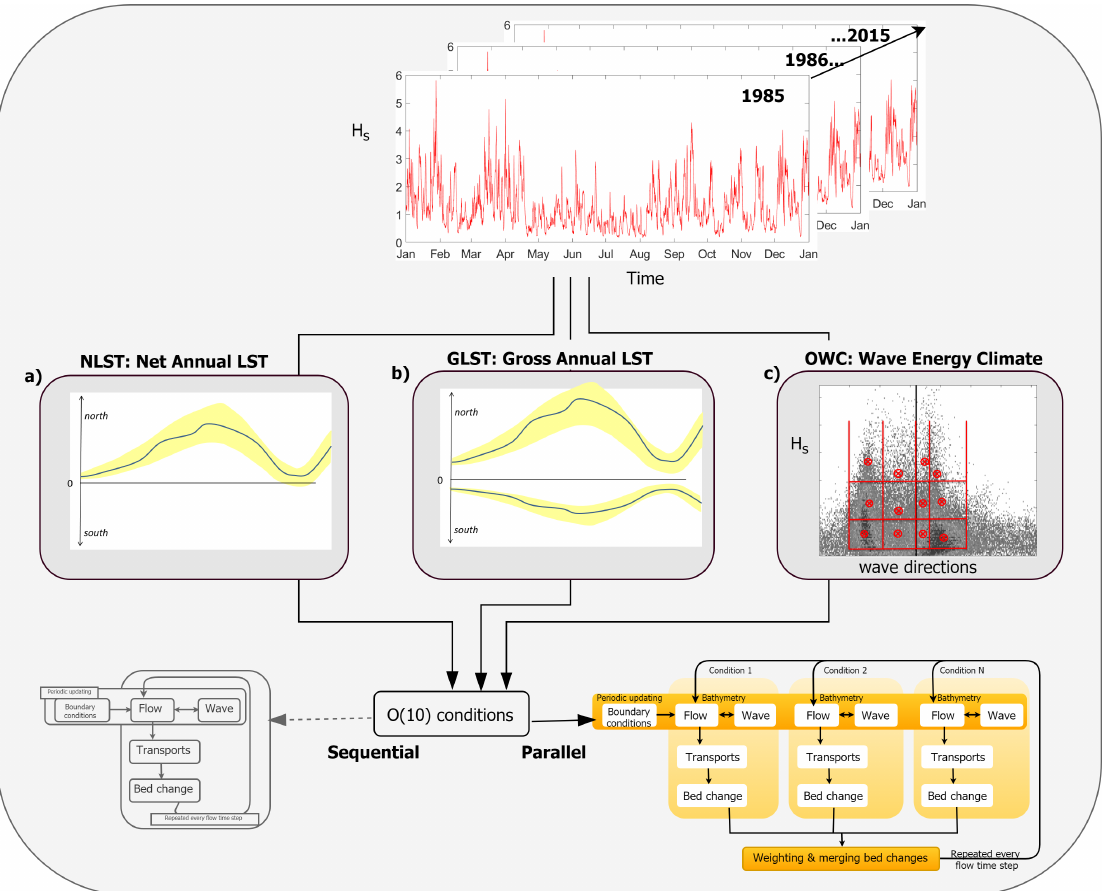
Figure 4. Graphical overview of the three considered morphodynamic acceleration techniques using representative (schematized) conditions: ( a ) NLST, ( b ) GLST and ( c )